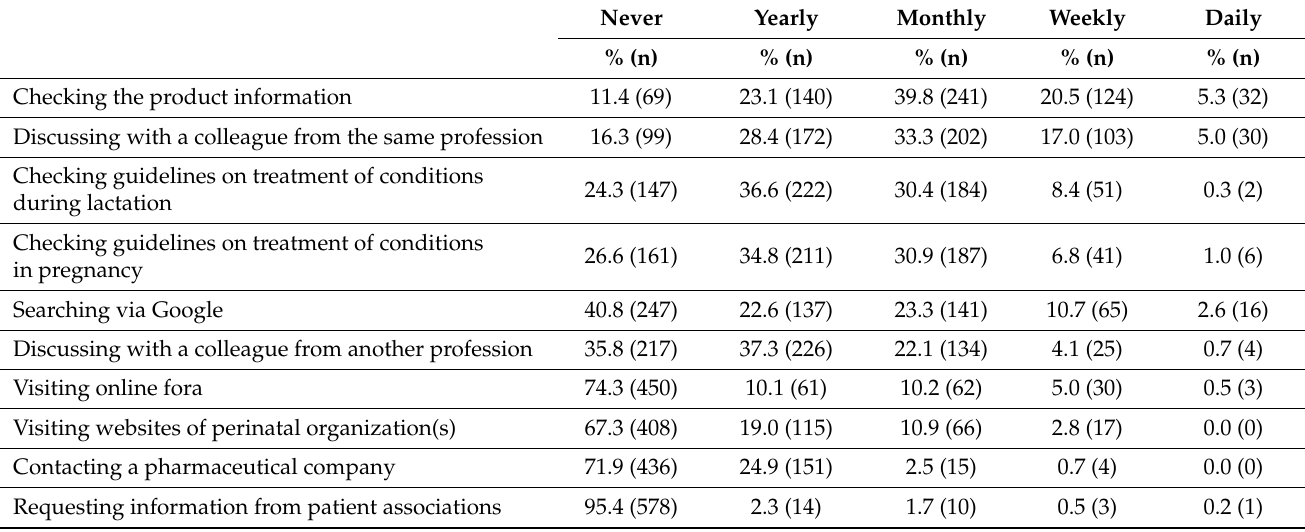
Table 3. Frequency of use by HCPs of some information sources regarding medication use during pregnancy/breastfeeding (N =